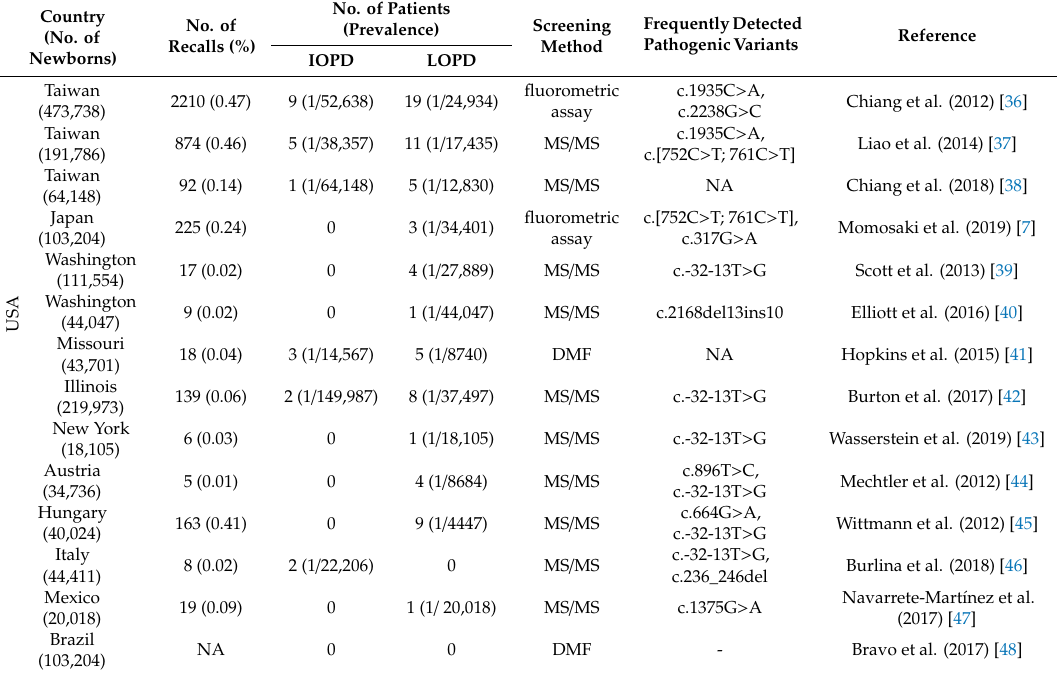
Table 1. Summary of NBS programs for Pompe disease.